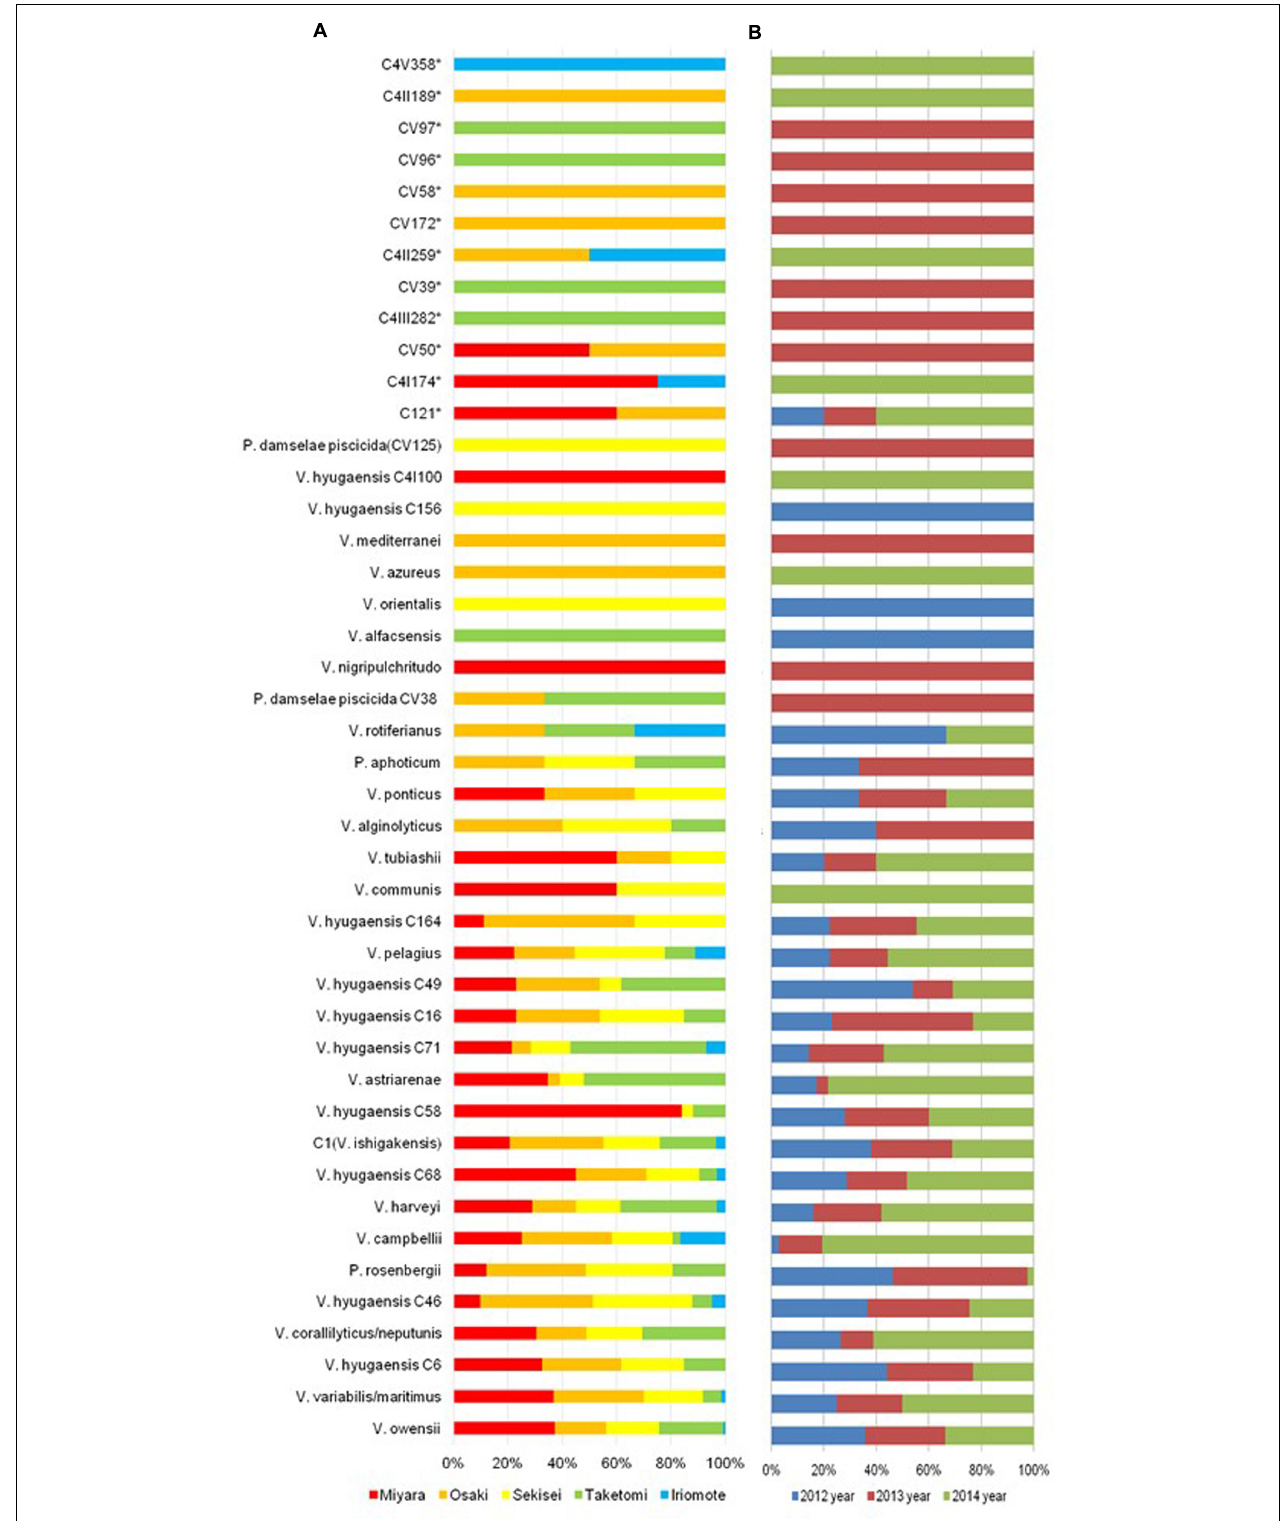
FIGURE 4 | Spatiotemporal Vibrio population dynamics in Ishigaki coral reef seawater. (A) Spatial Vibrio population dynamics (red, brown, yellow, green, sky blue colors indicate sampling sites of Miyara, Osaki, Sekisei Outer, Taketomi, and Iriomote respectively); (B) Temporal Vibrio population dynamics (blue, violate, and green colors indicate sampling year of 2012, 2013, and 2014 accordingly).